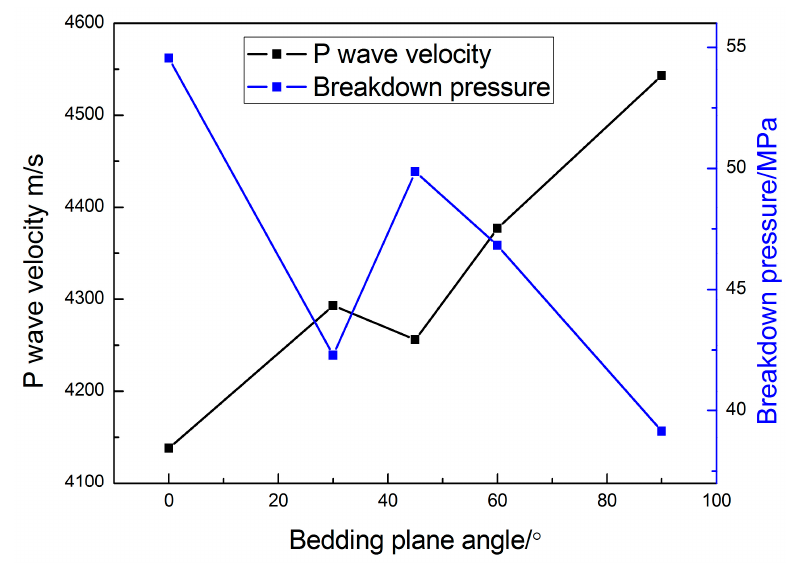
Figure 6. P wave velocity and breakdown pressure of shale samples with different bedding plane angles.